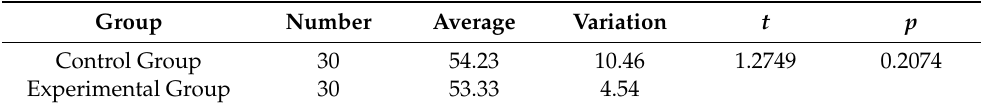
Table 2. Before the experiment, t -tests for the experimental group and control group. Group Number Average Variation t p Control Group